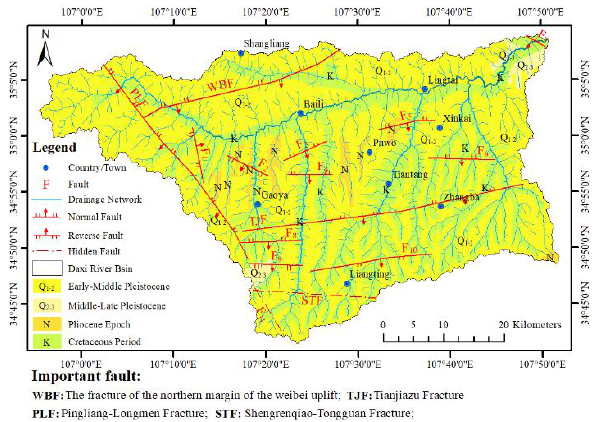
Figure 2. Geologic and fault distribution map of study area, the geological data were from Fan et al.